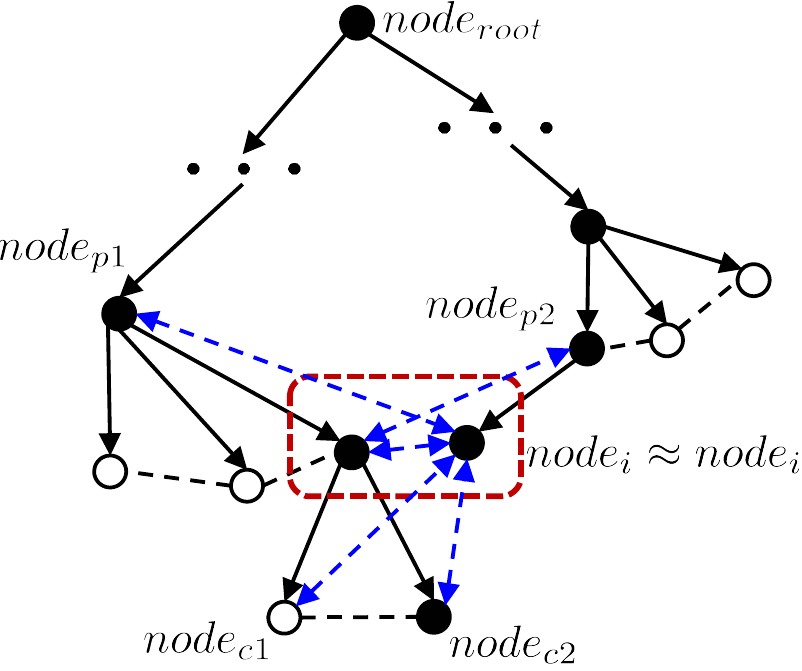
Figure 4. Registering the edges between the current and revisited nodes’ neighbors in the frontier node DB after accidental